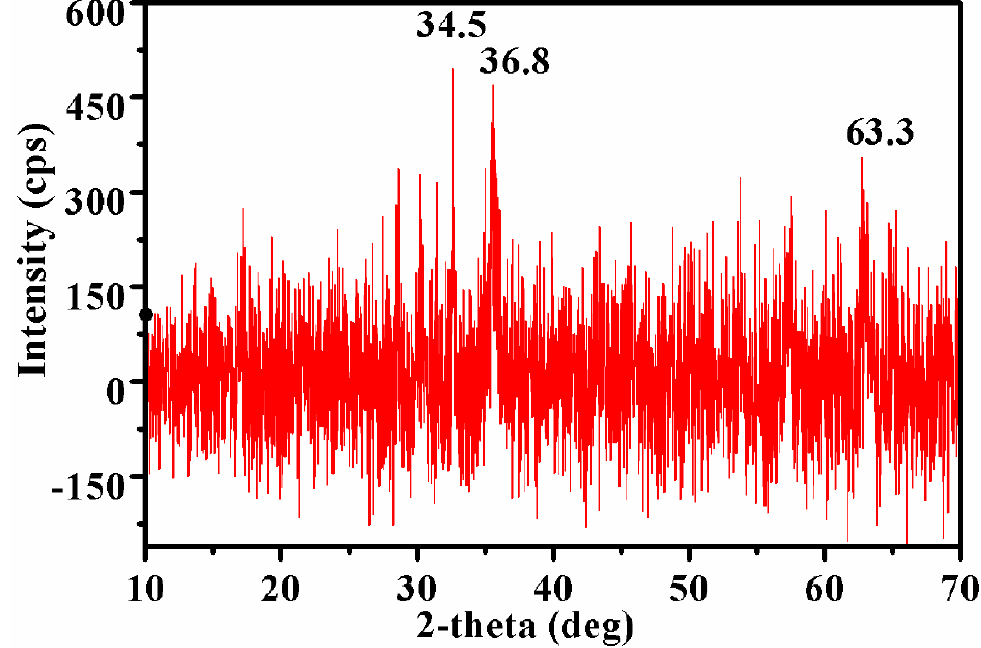
Figure 5. X-ray di ff raction (XRD) pattern of IONPs synthesized by sonochemical Figure 5. X-ray diffraction (XRD) pattern of IONPs synthesized by sonochemical method.